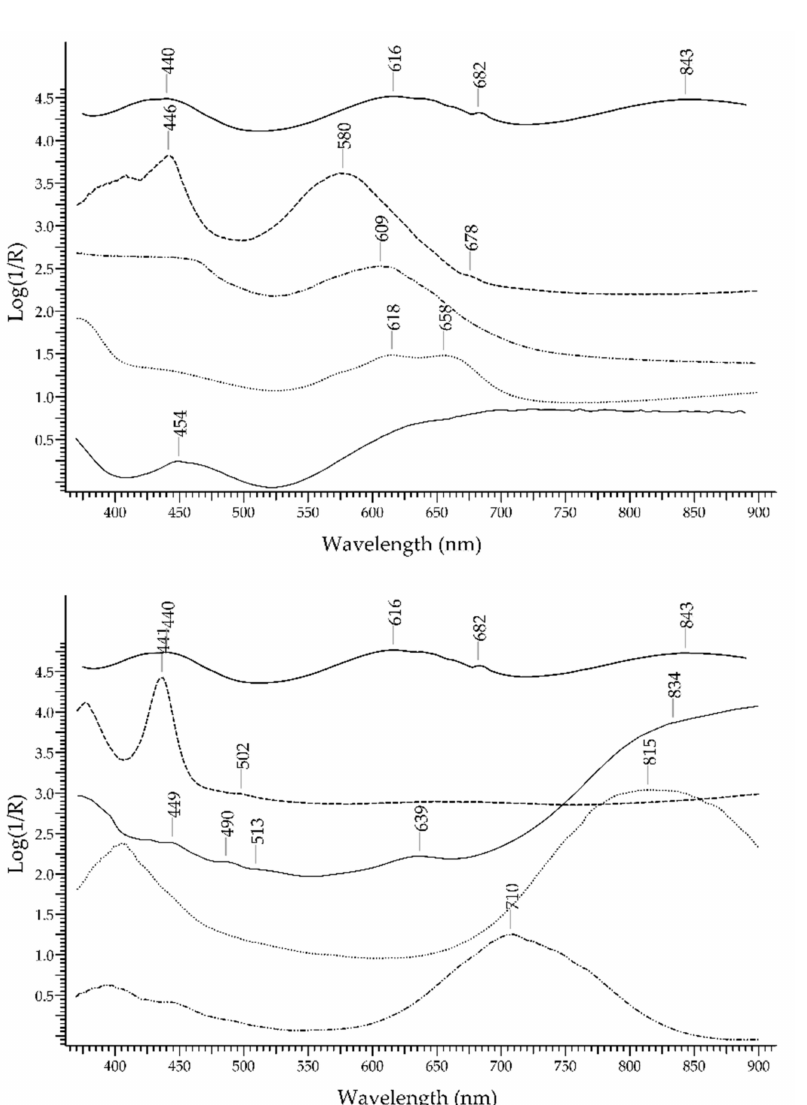
Figure 24. Top: FORS spectrum in Log(1/R) coordinates of emerald (solid line), alexandrite (dashed line), a green topaz (dotted line), a Cr 3+ containing green glass (dashed–dotted line) and a chrome– chalcedony (dashed–dotted–dotted line). Bottom: FORS spectrum in Log(1/R) coordinates of emerald (solid line), chrysoberyl (dashed line), heliodor (dotted line), peridot (dashed–dotted line) and a green tourmaline (dashed–dotted–dotted